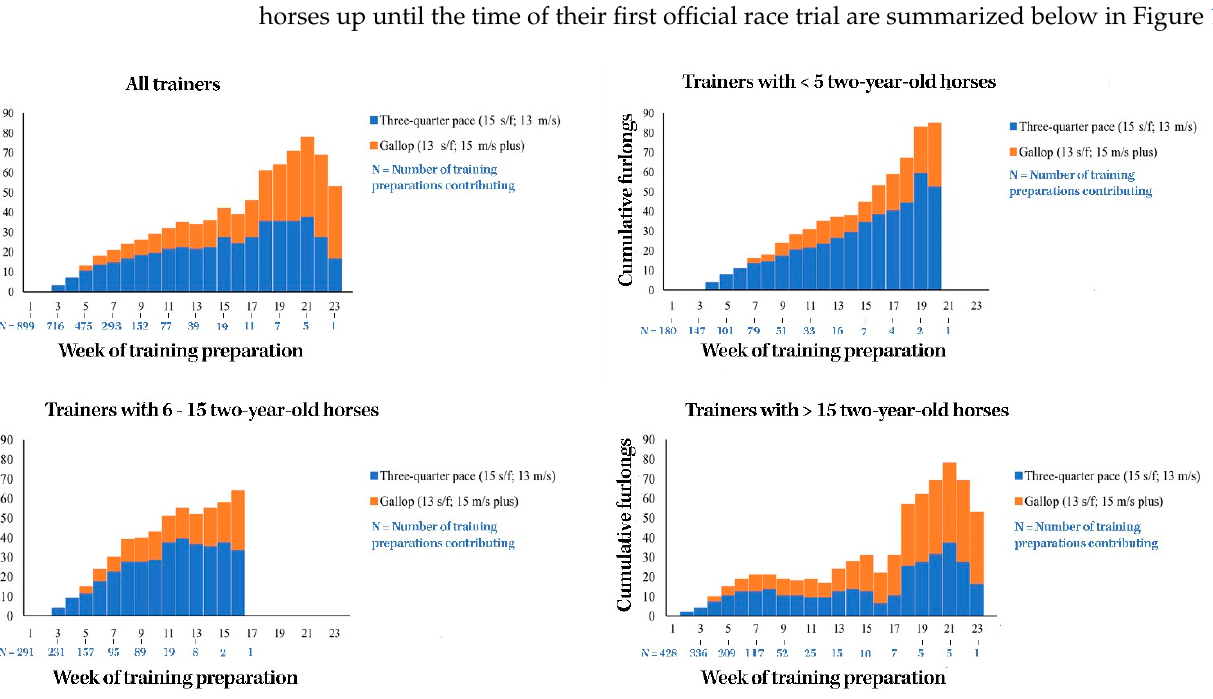
Figure 1. The median cumulative weekly high-speed exercise training volumes for two-year-old Thoroughbred racehorses up until the time of their first official race trial in Queensland, Australia.